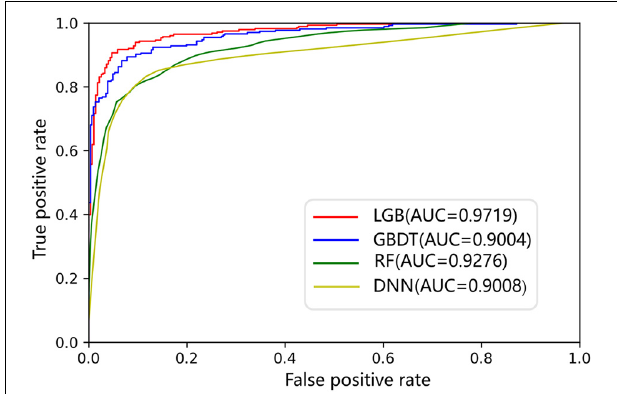
FIGURE 7 | ROCs of different models on the channel–drug interaction dataset.